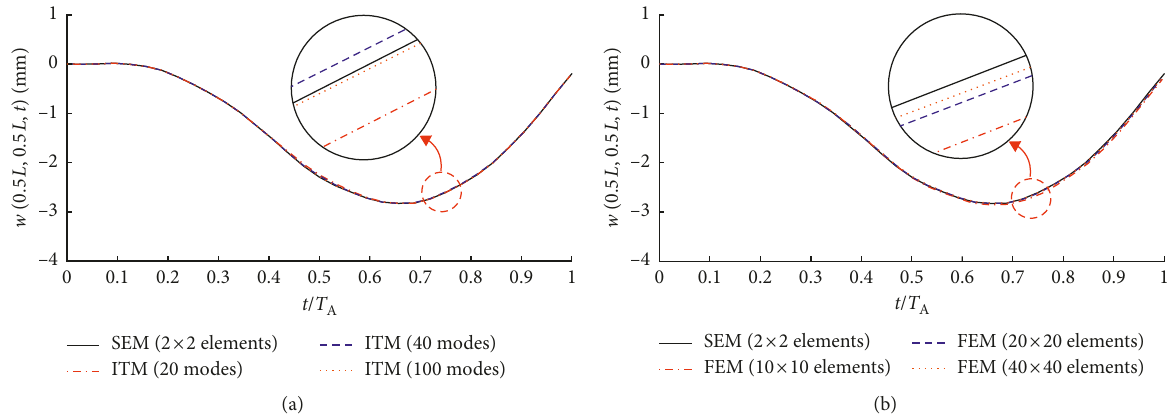
Figure 12: Comparison of the vibration responses obtained by the integral transform method (ITM) [5], FEM [14], and SEM at the center of the S-S-S-S square plate (Example 1) subjected to a moving point force whose trajectory is given by Case 1 of (39), where v 0 [5] versus SEM. (b) FEM [14] versus